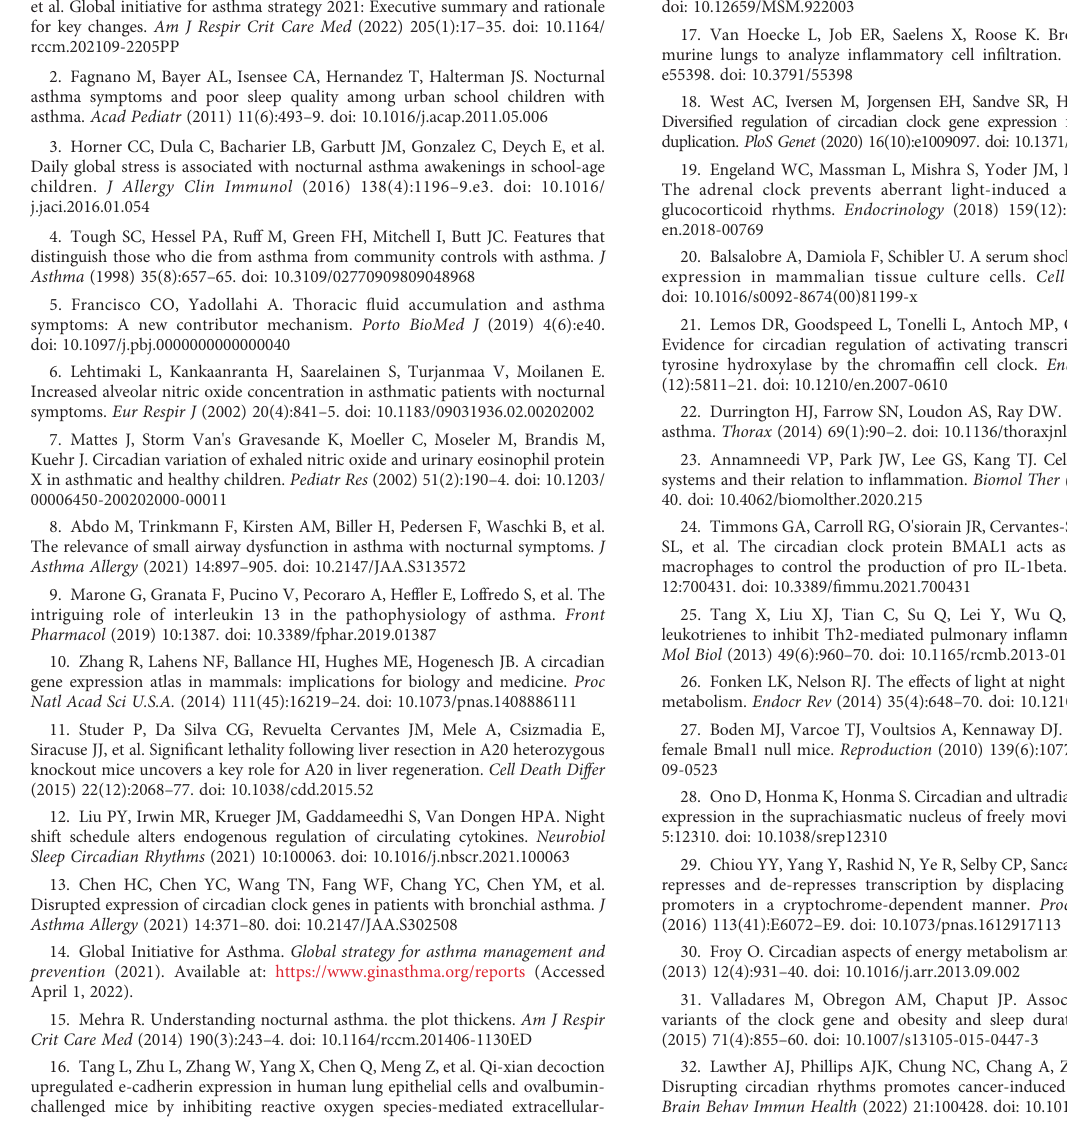
SUPPLEMENTARY TABLE 1 The target sequences of shRNAs.